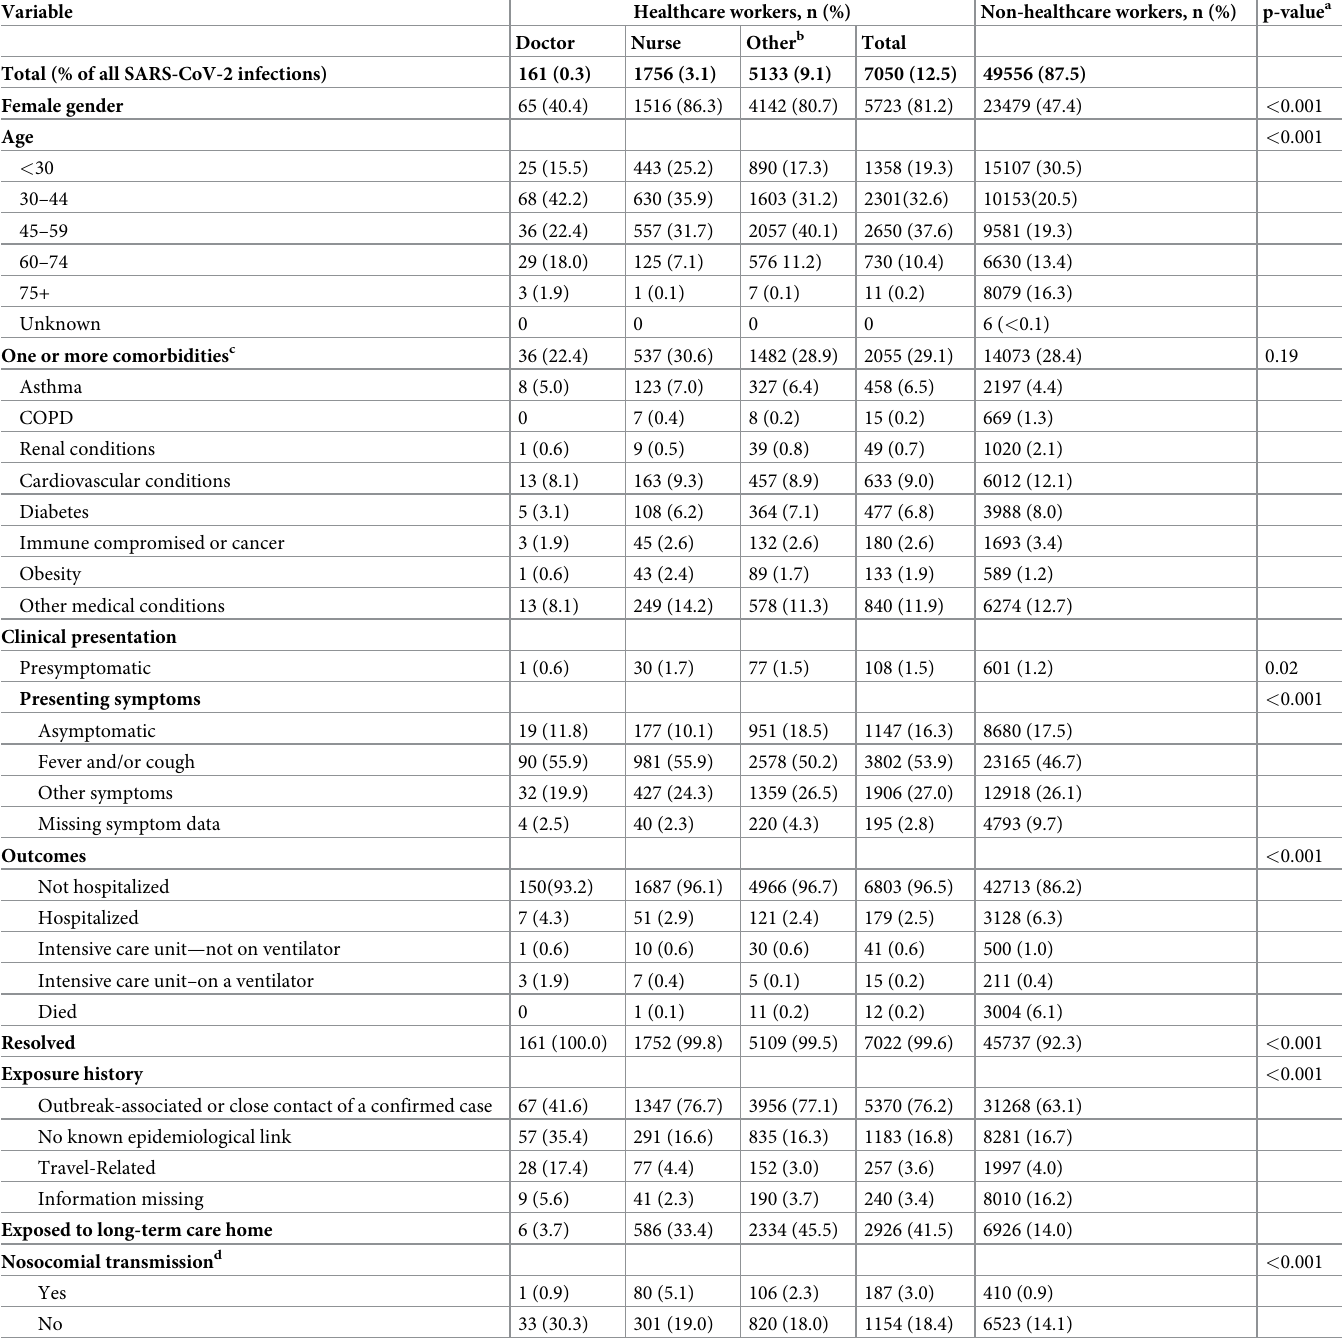
Table 1. Clinical, demographic and exposure comparison between healthcare workers and non-healthcare workers with SARS-CoV-2 infection (n = 56,606).